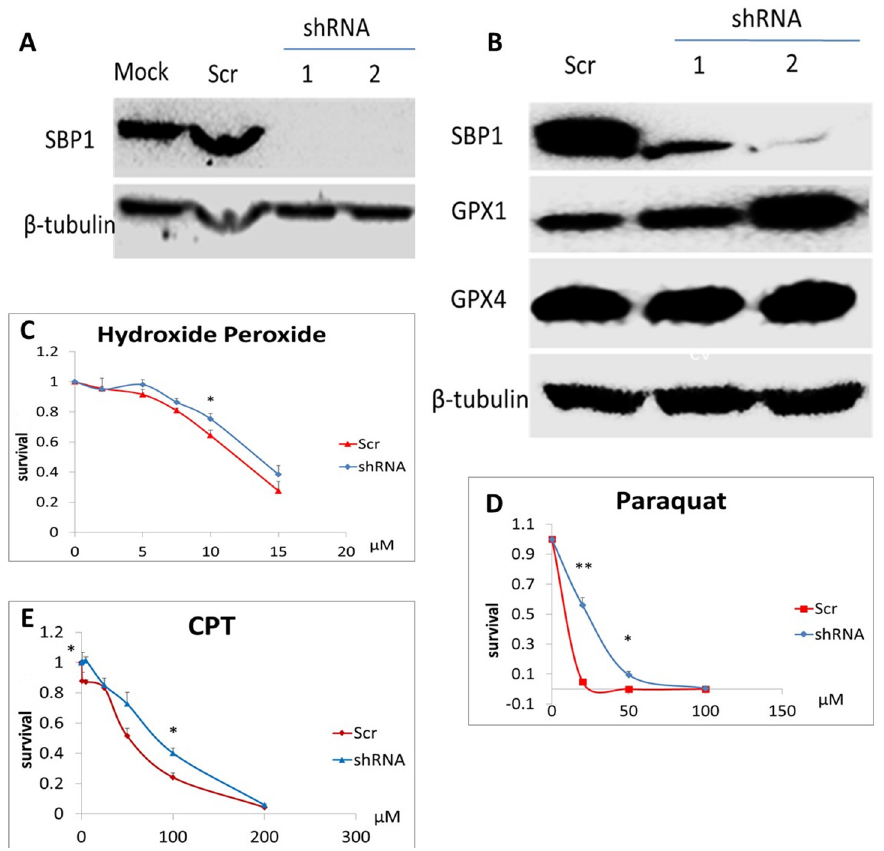
Fig 1. Knockdown of SBP1 desensitized HeLa cells to three clastogens and increased GPX1 protein levels. (A) Efficacy of SBP1 shRNA knockdown in two clones of HeLa cells as evidenced by Western analysis. (B) Effect of SBP1 knockdown on the protein levels of GPX1 and GPX4 by Western analysis. (C-E) Clonogenic assays were employed to determine sensitivity of scrambled and SBP1 shRNA HeLa cells to hydrogen peroxide (2 – 15 μ M, C), paraquat (20 – 100 μ M, D), and camptothecin (CPT, 5 – 200 μ M, E) for 24 h, followed by a 7-day recovery and then crystal violet staining for detection of viable colonies. Values are means ± SEM (n = 3). * , p < 0.05 and ** , p < 0.01, compared to scrambled shRNA HeLa cells.